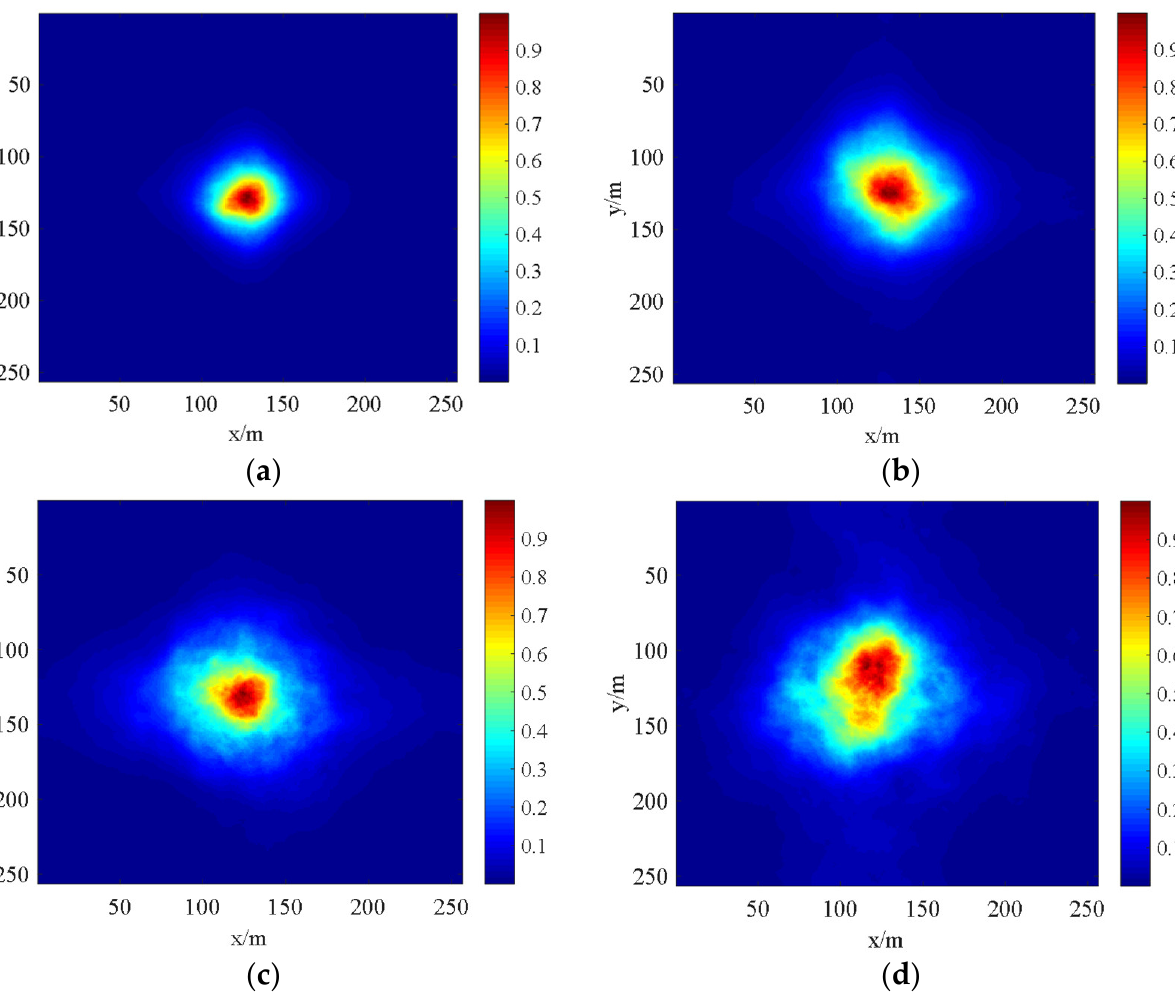
Figure 10. Light intensity distribution of the laser beam on the vertical path ( a ) ∆ z = 75 m, L = 1000 m, ( b ) ∆ z = 75 m, L = 2000 m, ( c ), ∆ z = 200 m, L = 1000 m ( d ) ∆ z = 200 m, L = 2000 m. . = 2 × 10 − 15 , L = 0.5 m and N × N = 256 × 256, after When the conditions are C 2 n changing the distance between the phase screens ( ∆ z ) and the transmission distance ( L ), respectively, the light intensity distribution of the laser beam passing through the phase screen are shown as (a), (b), (c) and (d). For the light intensity distribution of the laser transmission on the vertical path, the spot drift phenomenon occurs. Figure 11 shows the spot drift phenomenon. In Figure 11, the hexagon indicates the original spot centroid located in the middle, while the triangle shows the centroid of the drifted spot. It is clear that the larger the value of the phase screen spacing ∆ z is, the greater the discrete degree of the spot and the more obvious the phenomenon of light spot